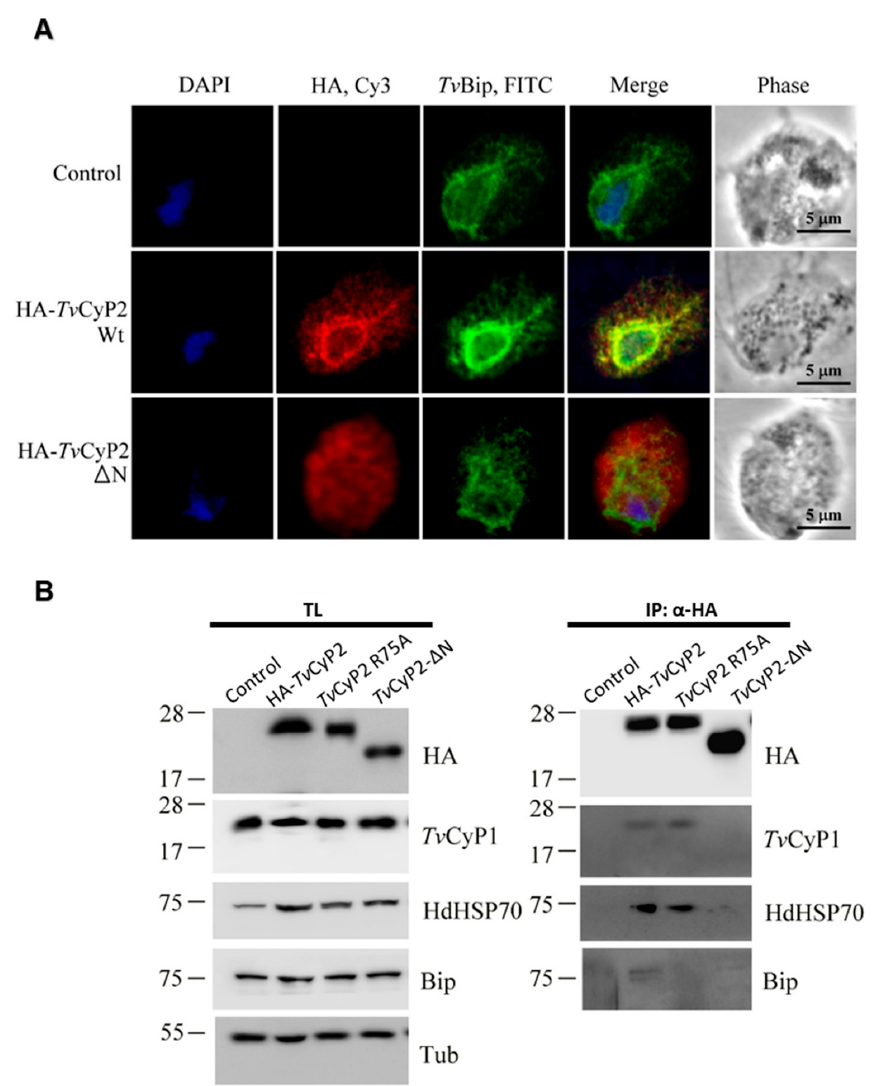
Figure 7. ( A ) Subcellular localization of hemagglutinin cyclophilin 2 (HA-CyP2) and HA-CyP2- ∆ N in Trichomonas vaginalis were determined by immunofluorescence assay (IFA). The two transgenic and non-transgenic parasites (control) were double-stained by the mouse anti-HA and rabbit anti- Tv Bip antibodies, followed by reacting with Cy3- and FITC-conjugated secondary antibodies. The Cy3 and FITC signals indicated the HA-CyP2 and Tv Bip localization, respectively. Nuclei were stained by DAPI. Fluorescence signal was observed by a confocal microscope. ( B ) Total lysates (TL) extracted from transgenic and non-transgenic parasites (control) were examined by Western blotting (left panel), or further immunoprecipitated (IP) by the agarose beads conjugated with anti-HA antibody for subsequent Western blot detection (right panel). The detected proteins by Western blot were indicated at the right side, and molecular weights were labeled at the left side of each panel.